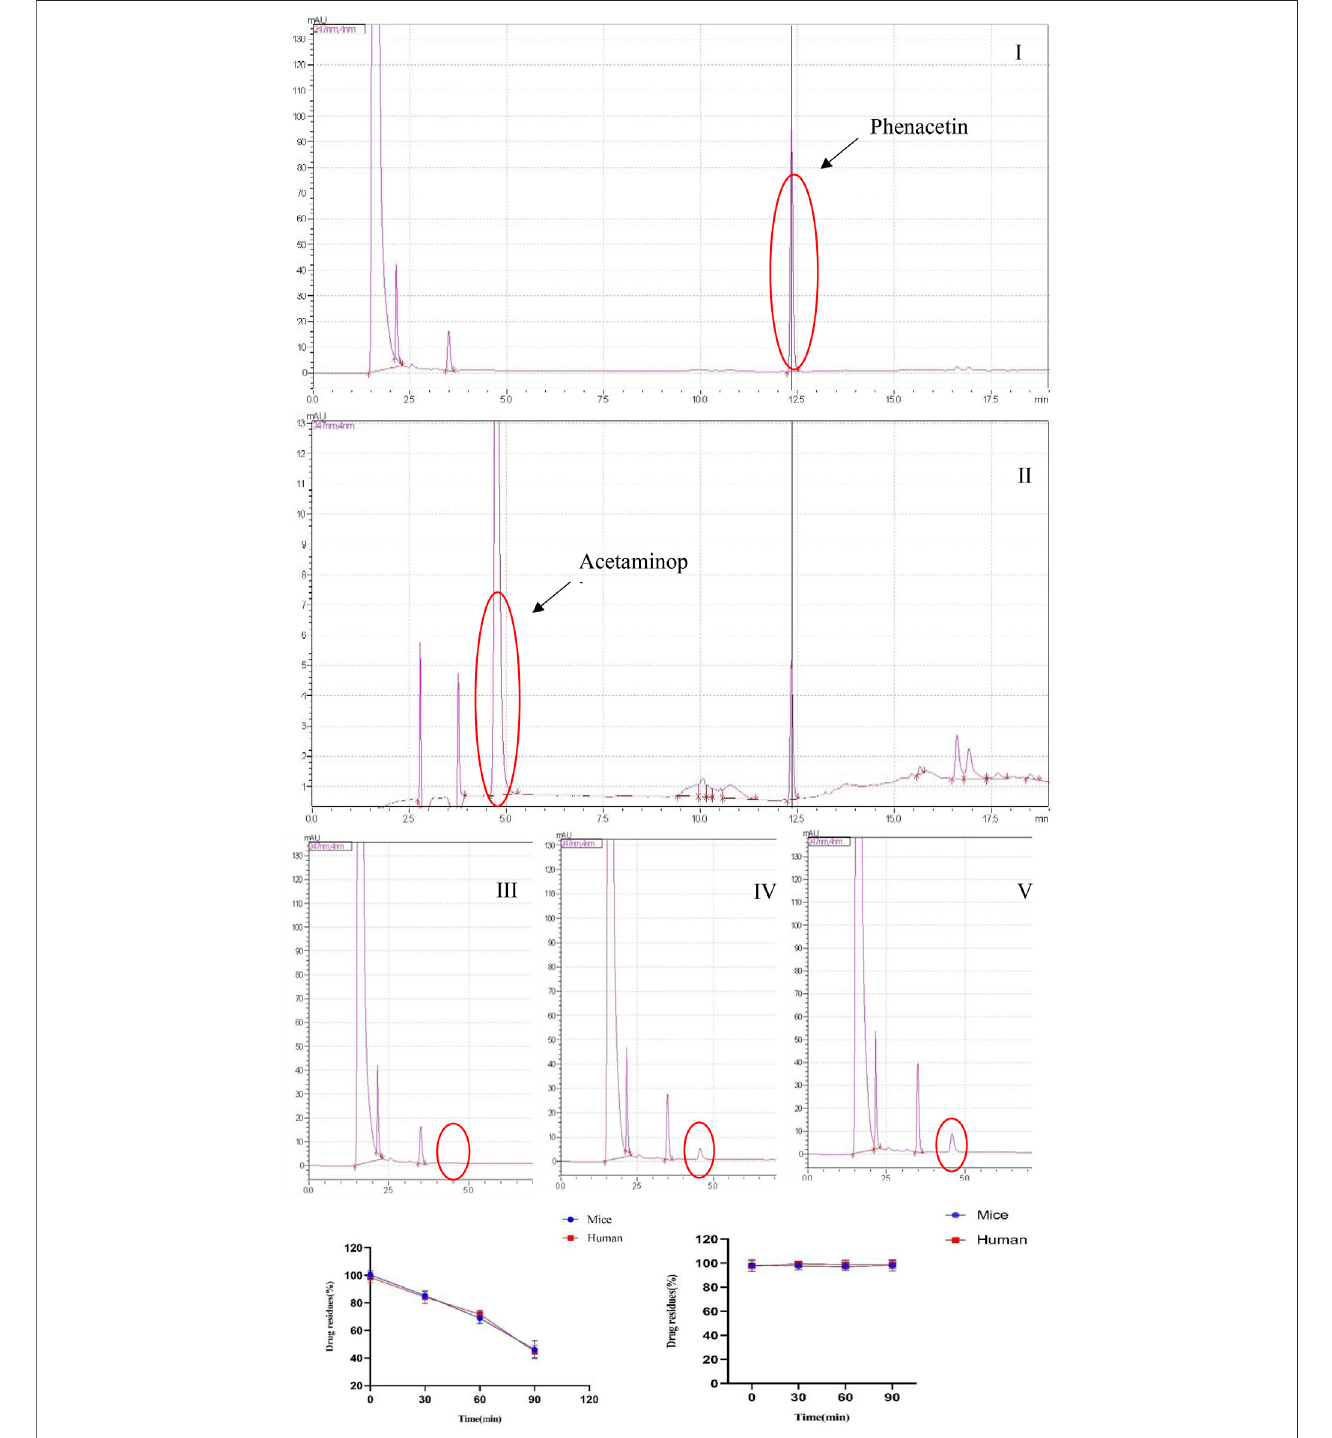
FIGURE 3 | (A) Selected reaction monitoring chromatograms of phenacetin (I), acetaminophen (II), the peak of metabolite acetaminophen at 0 min (III), the peak of metabolite acetaminophen at 30 min (IV), and the peak of metabolite acetaminophen at 60 min (V) in the human liver microsomes. (B) Stability of phenacetin (I) and YWS01125 (II) in mice and human liver microsomes.